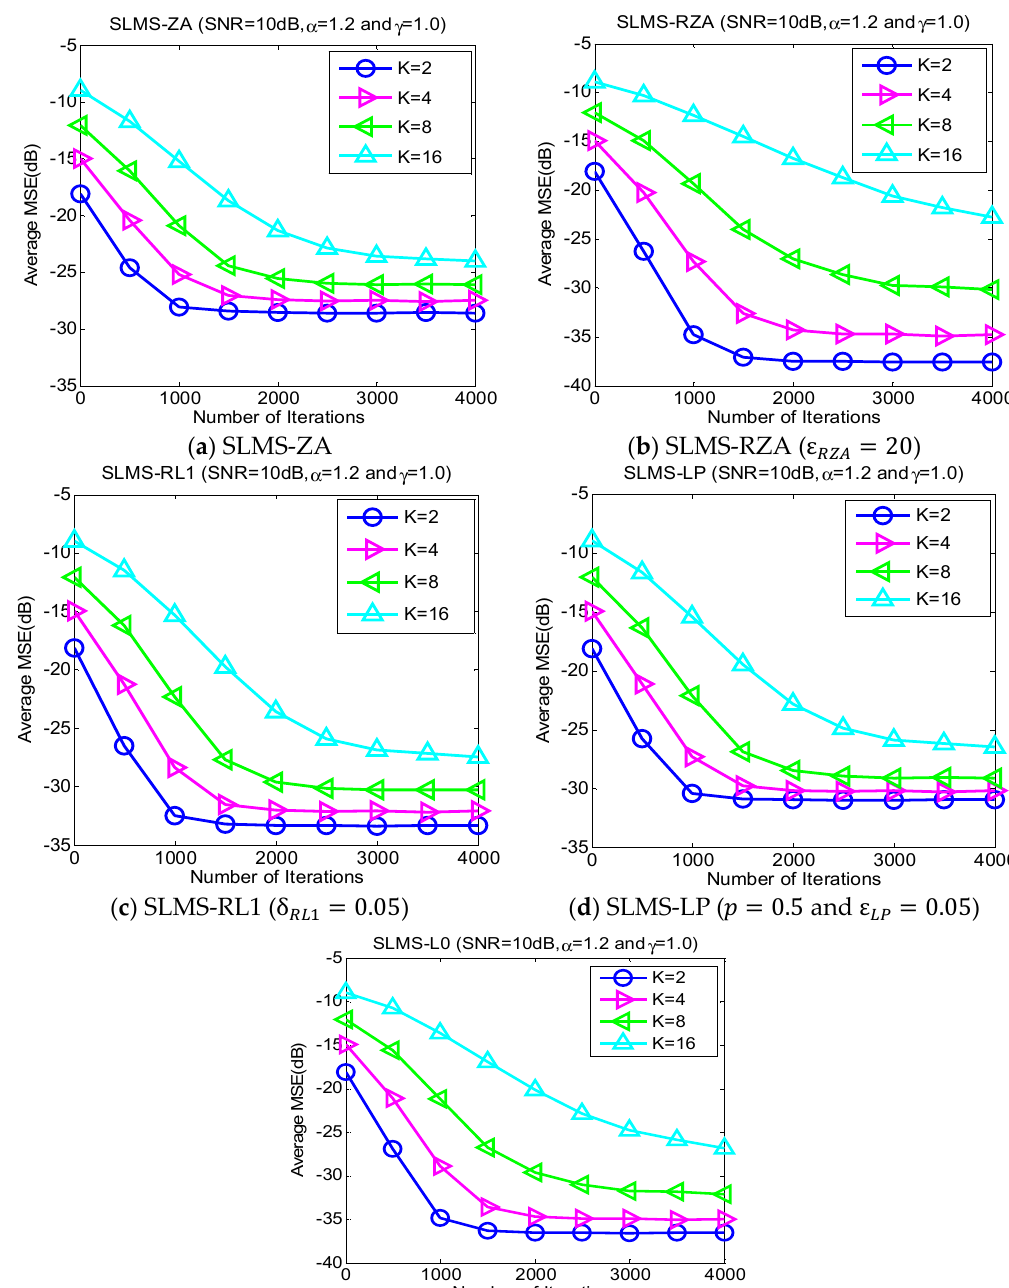
Figure 3. Monte Carlo based MSE curves averaging over 1000 runs with respect to different channel sparsities K ∈ { 2, 4, 8, 16 } , in scenarios of characteristic exponent α = 1.2, dispersion parameter γ = 1.0, channl length N = 128, and SNR = 10